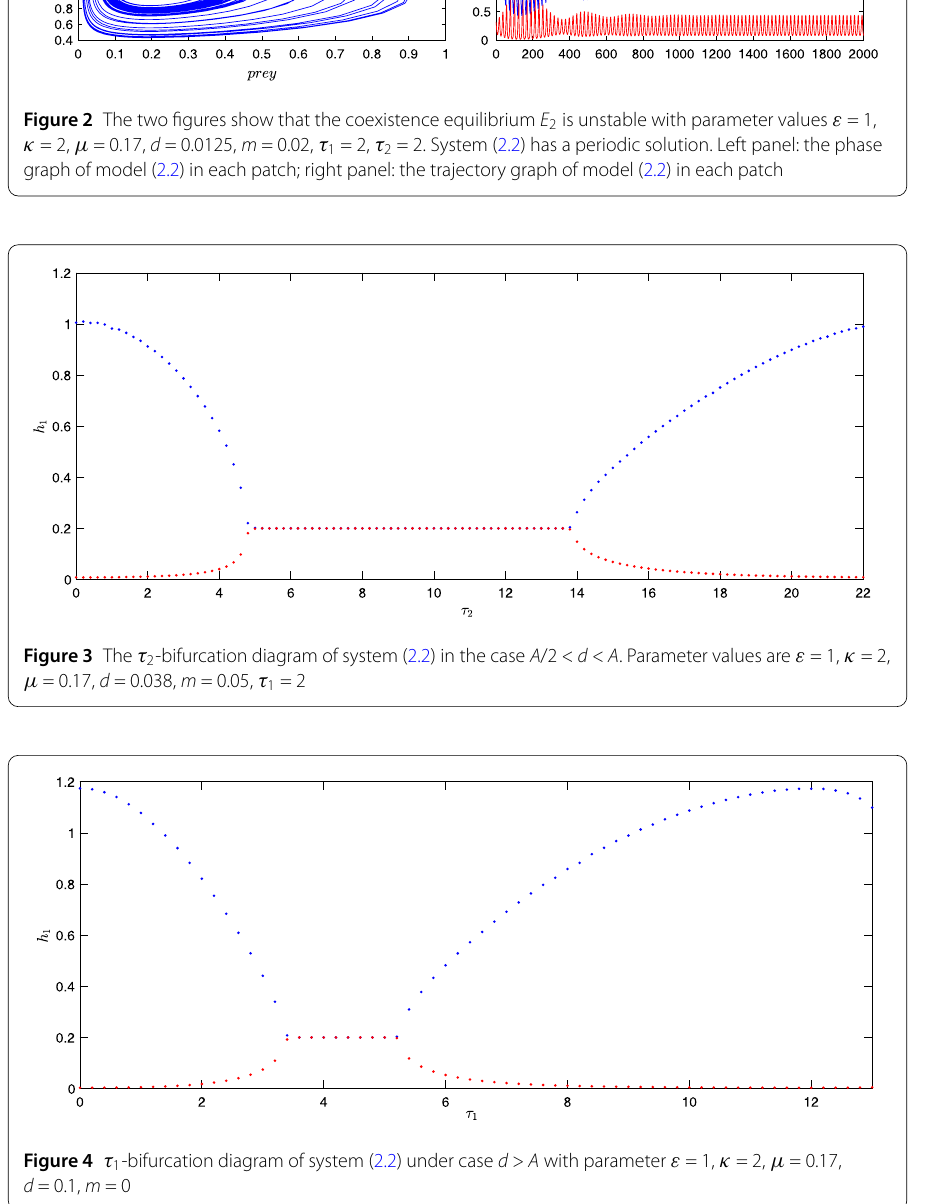
diagram of (2.2) with m = 0 in each cases. Then we choose values of τ 1 in its stable intervals and unstable intervals, respectively. We regard τ 2 as bifurcation parameter and display the bifurcation diagram of